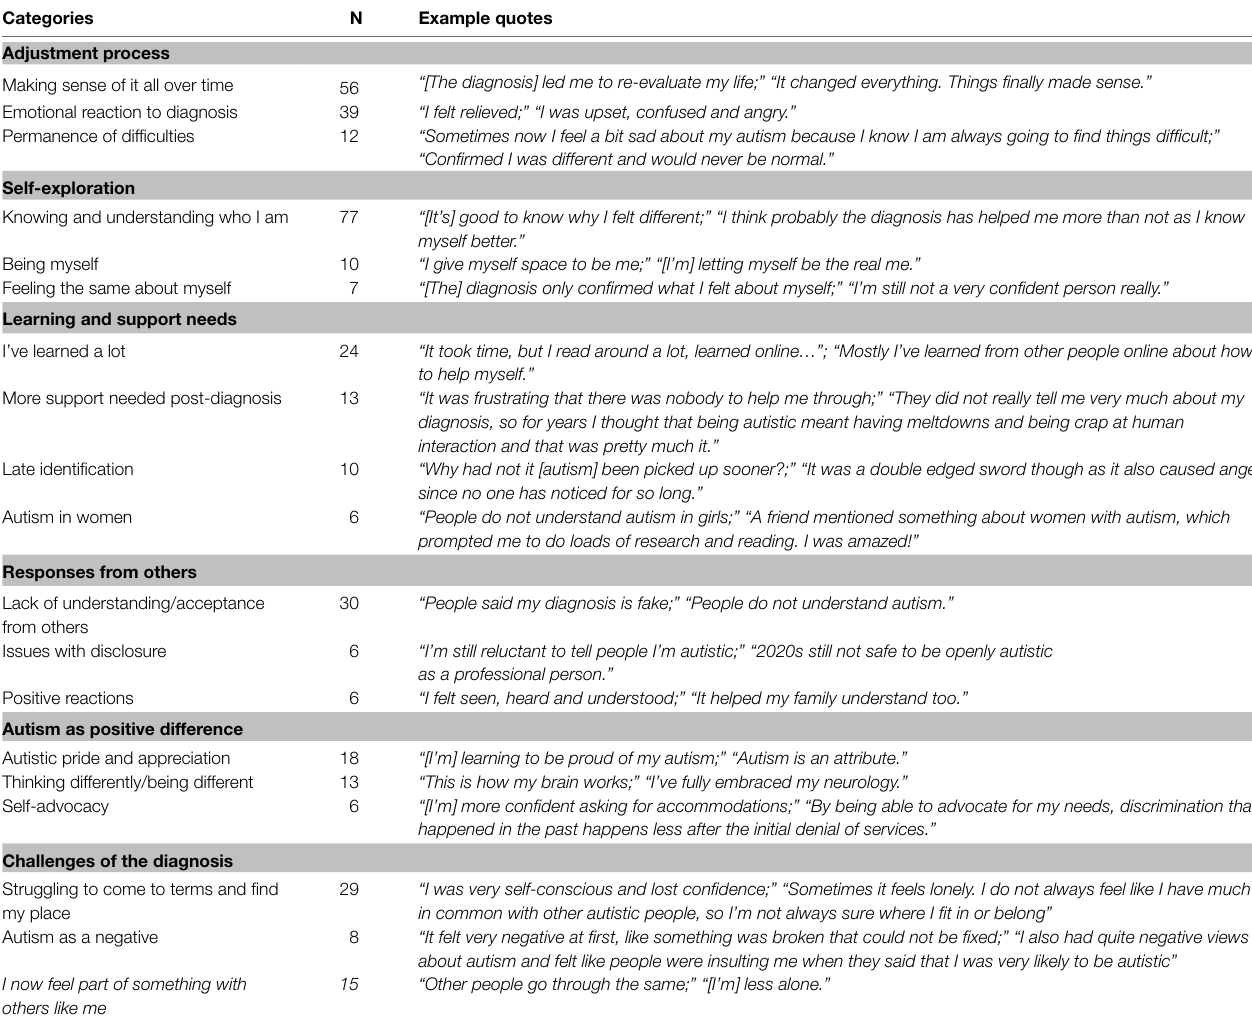
TABLE 7 | Categories and sub-categories identified in relation to the qualitative question about receiving an autism diagnosis.